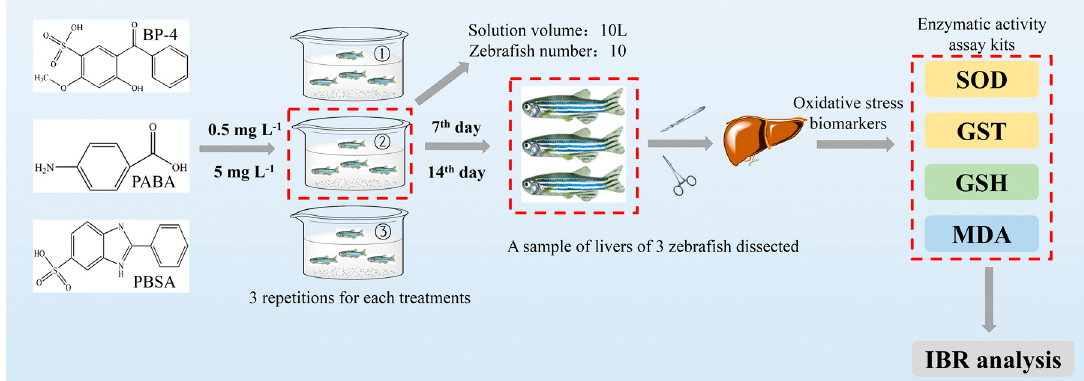
Figure 1. The testing procedures for oxidative stress evaluation of BP-4, PABA, and PBSA in zebrafish liver.